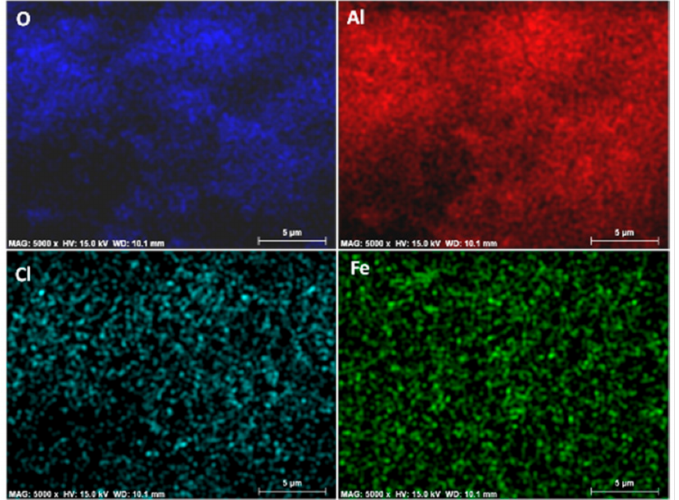
Figure 2. Mapping of the elemental distributions in sample FeAlR-1123 (oxygen, aluminum, chloride, and iron) by EDX chemical